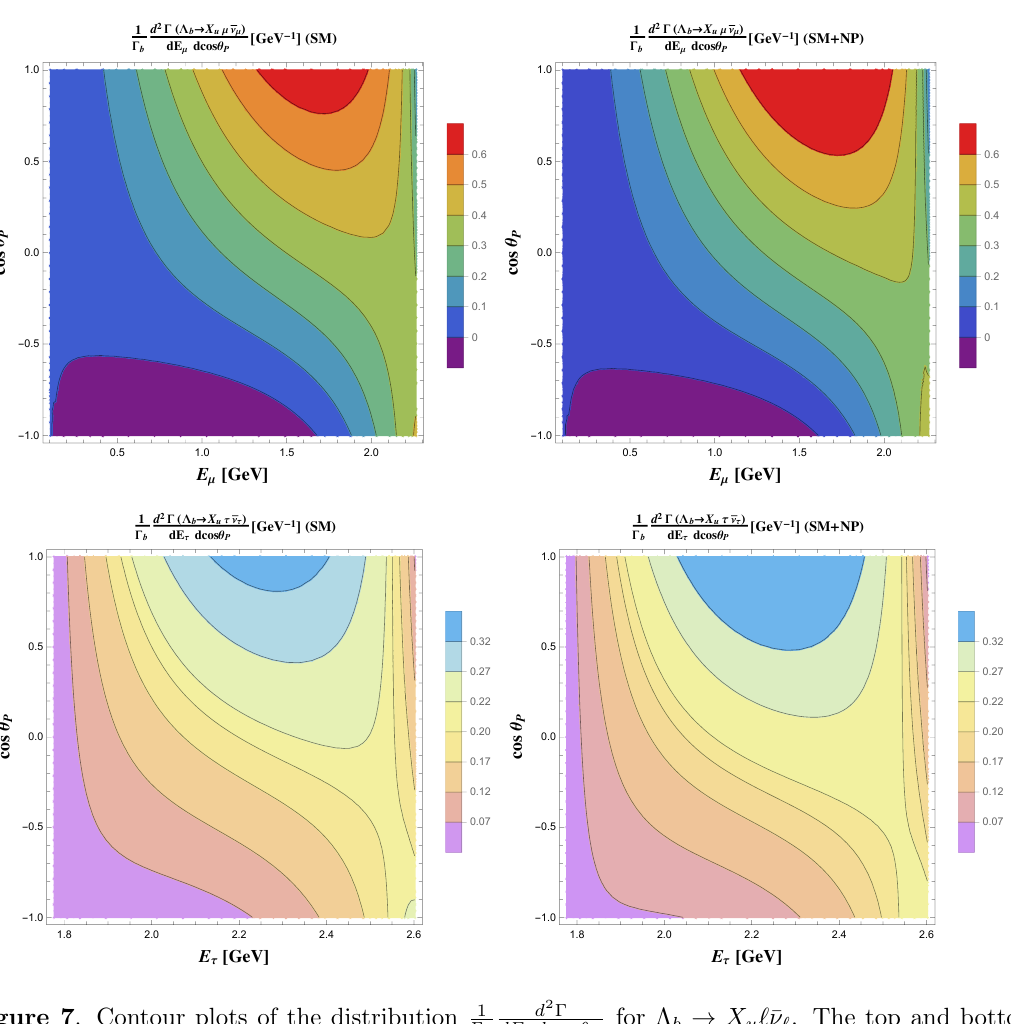
Figure 7 . Contour plots of the distribution 1 panels refer to ‘ = (cid:22) and ‘ = (cid:28) , respectively, the left and right panels to the Standard Model and to NP at the benchmark point.